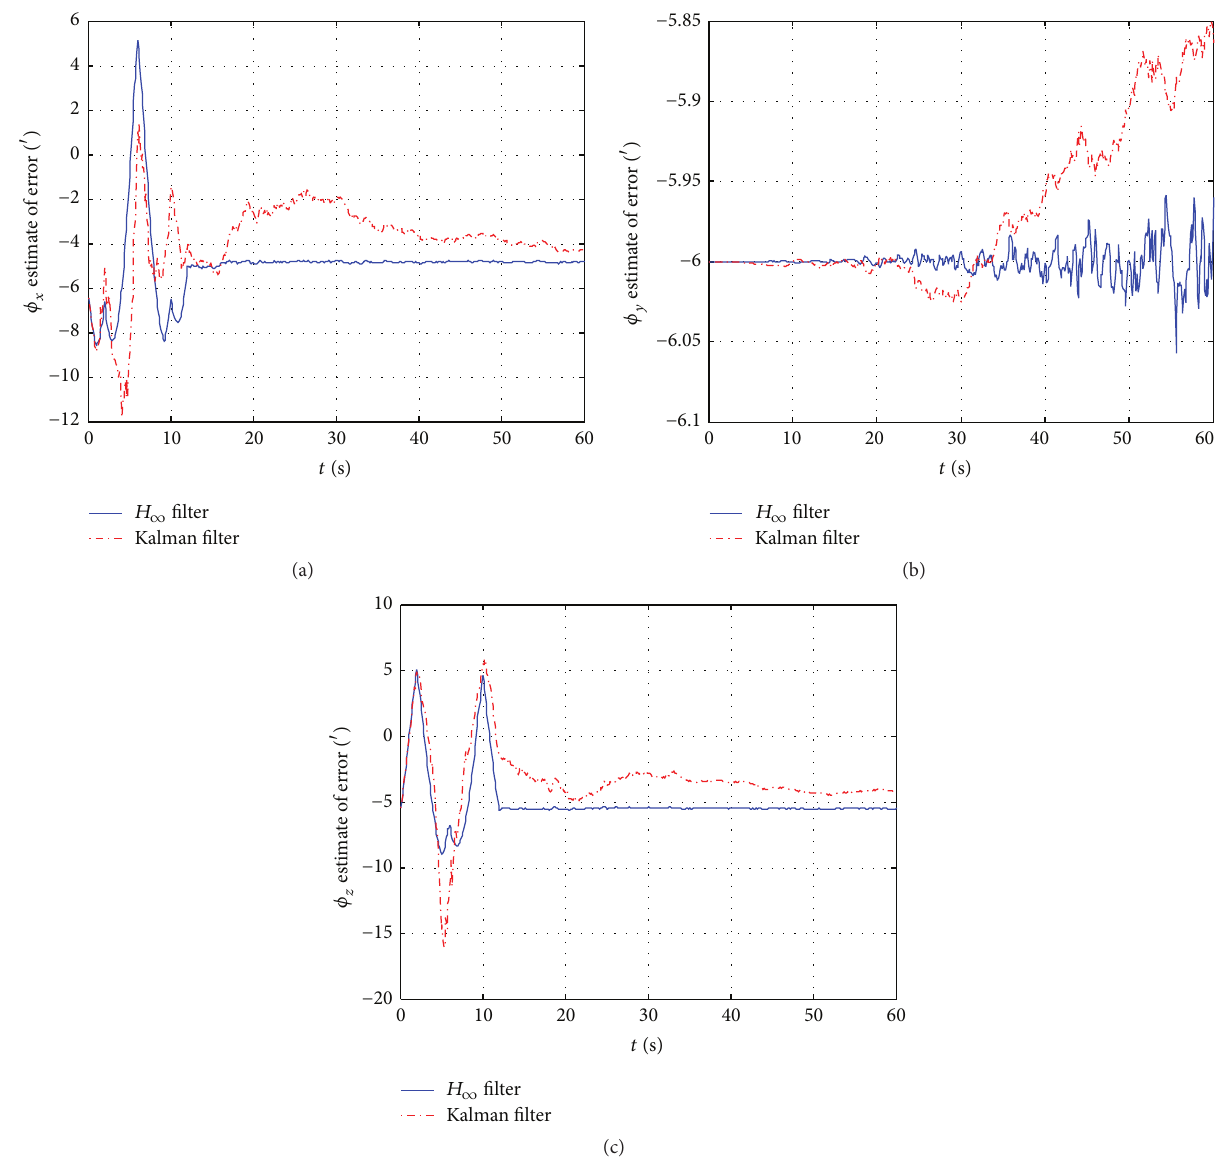
Figure 5: Estimate error of misalignment angle.